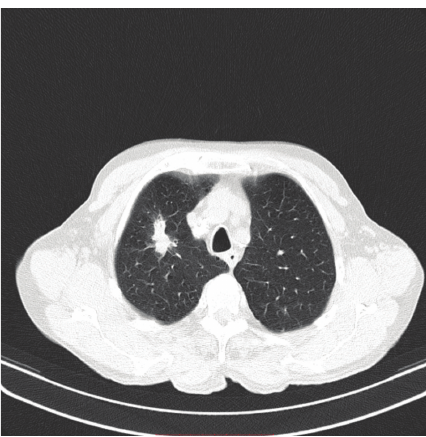
Figure 1: CT-scan of the chest showing an irregular elongated shadow in apical segment of right upper lobe.